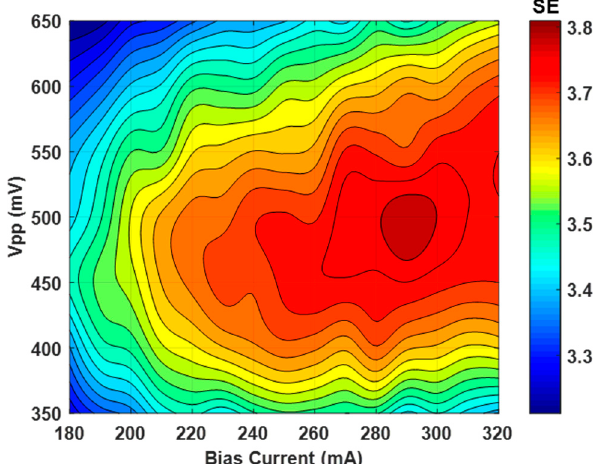
Figure 6. Average QAM order versus DC bias current and signal V pp. SE represents the spectrum efficiency.